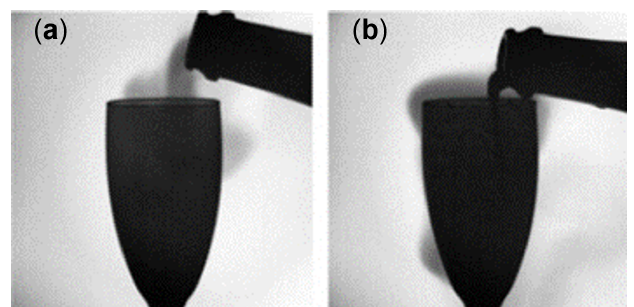
Figure 7. Infrared snapshots, adapted from Liger-Belair et al. [27], showing the behavior of gas-phase CO 2 during pouring of champagne in a flute. While tilting the champagne bottle, some gas-phase CO 2 (denser than ambient air and initially trapped in the corked bottleneck) falls in the headspace of the flute ( a ) before champagne started to flow through the bottleneck a split-second later ( b